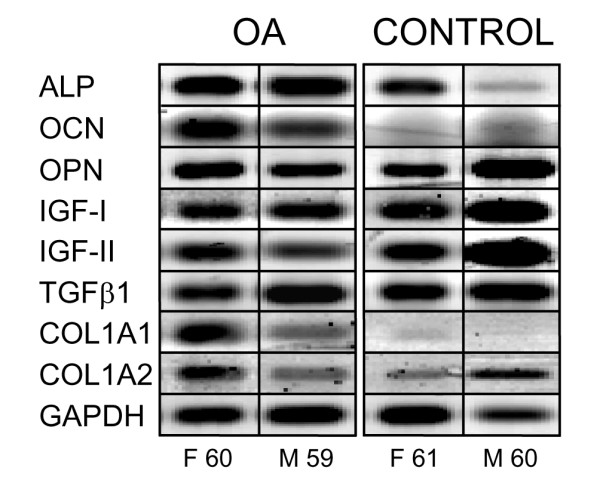
Representative gene expression as determined by semi-quantitative reverse transcription-polymerase chain reaction (PCR) using total RNA extracted from intertrochanteric trabecular bone. Target genes included alkaline phosphatase (ALP) (434 bp), osteocalcin (OCN) (159 bp), osteopontin (OPN) (472 bp), insulin-like growth factor (IGF)-I (344 bp), IGF-II (263 bp), transforming growth factor-β1 (TGF-β1) (224 bp), COL1A1 (339 bp), COL1A2 (778 bp), and the housekeeping gene GAPDH (415 bp). Specimens were obtained from a 60-year-old female (F 60) and a 59-year-old male (M 59) undergoing total hip replacement for primary osteoarthritis (OA). The control specimens were obtained at autopsy from a 61-year-old female (F 61) and a 60-year-old male (M 60) without any bone-related disease. PCR products representing each mRNA species were visualised on SYBR Gold®-stained 2% agarose gels. COL1A, collagen type I alpha chain; GAPDH, glyceraldehyde-3-phosphate dehydrogenase.